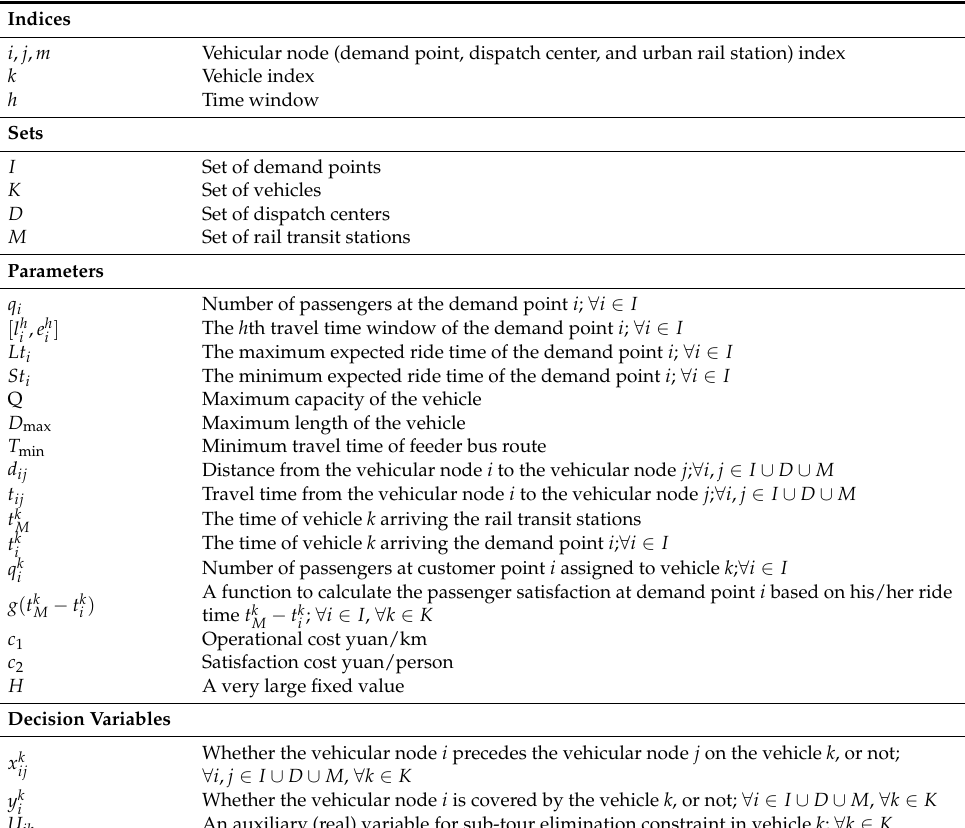
Table 1. Parameters and variables in the mathematical model.